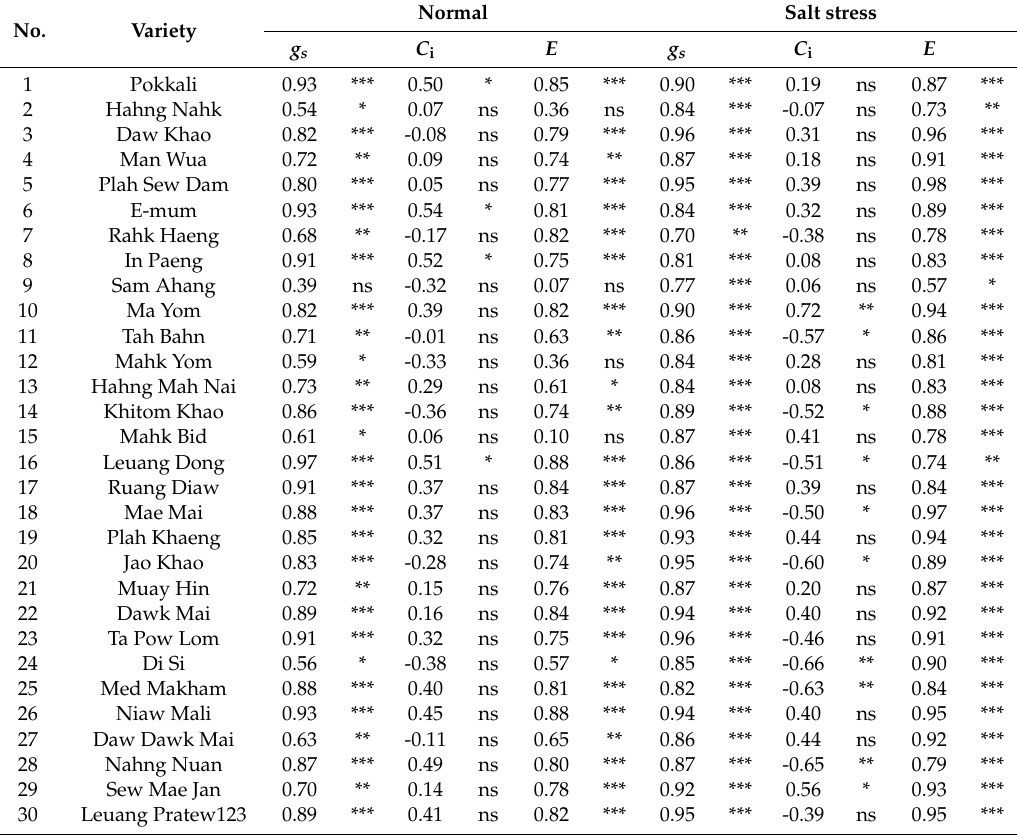
Table 1. Correlation between P N and other photosynthetic parameters g s , C i and E ) in the penultimate leaves of each rice varieties at flowering stage grown under normal and salt stress condition for 0, 3, 6, and 9 days.